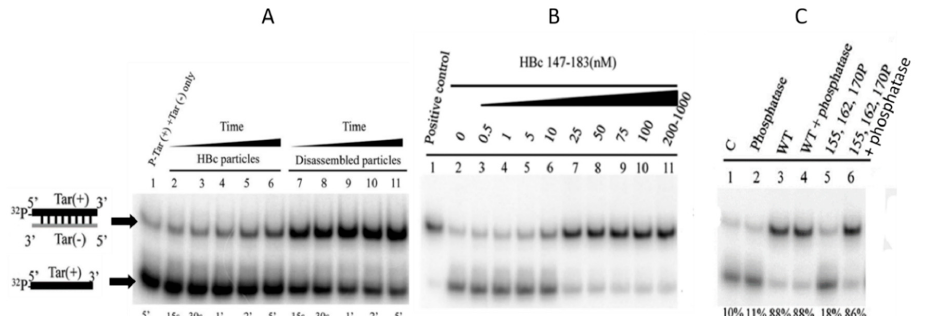
Figure 7. HBc and HBc (147–183) nucleic acid chaperone activity. ( A ): Tar(+)/Tar(-) duplex formation by assembled and disassembled capsids. ( B ): Tar(+)/Tar(-) duplex formation mediated by HBc